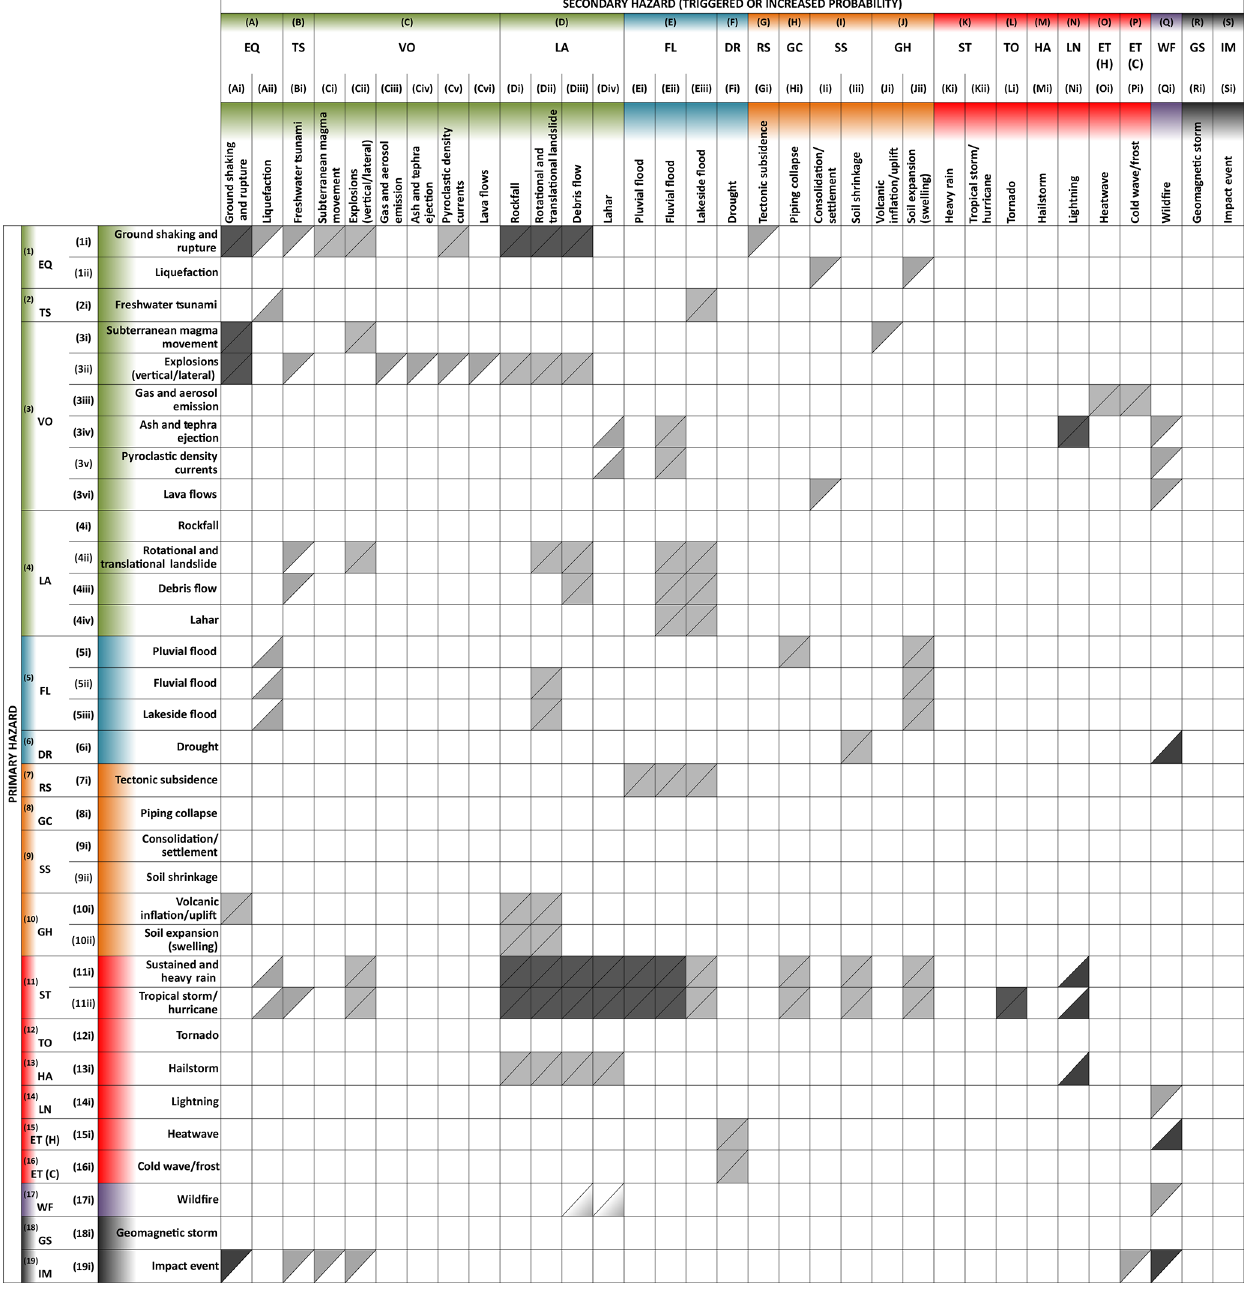
Figure 4. Southern Guatemalan Highlands (sub-national) interaction framework, Guatemala. A 33 × 33 matrix with 33 primary natural-hazard sub-types on the vertical axis, and the same 33 natural-hazard sub-types presented as secondary hazards on the horizontal axis. Interactions (shaded triangles in cells) include primary hazards triggering a secondary hazard (upper left triangle shaded in cell) and primary hazards increasing the probability of a secondary hazard occurring (lower right triangle shaded in cell). This matrix is populated using different evidence types, as outlined through Sect. 2. See Fig. 3 legend for symbols and